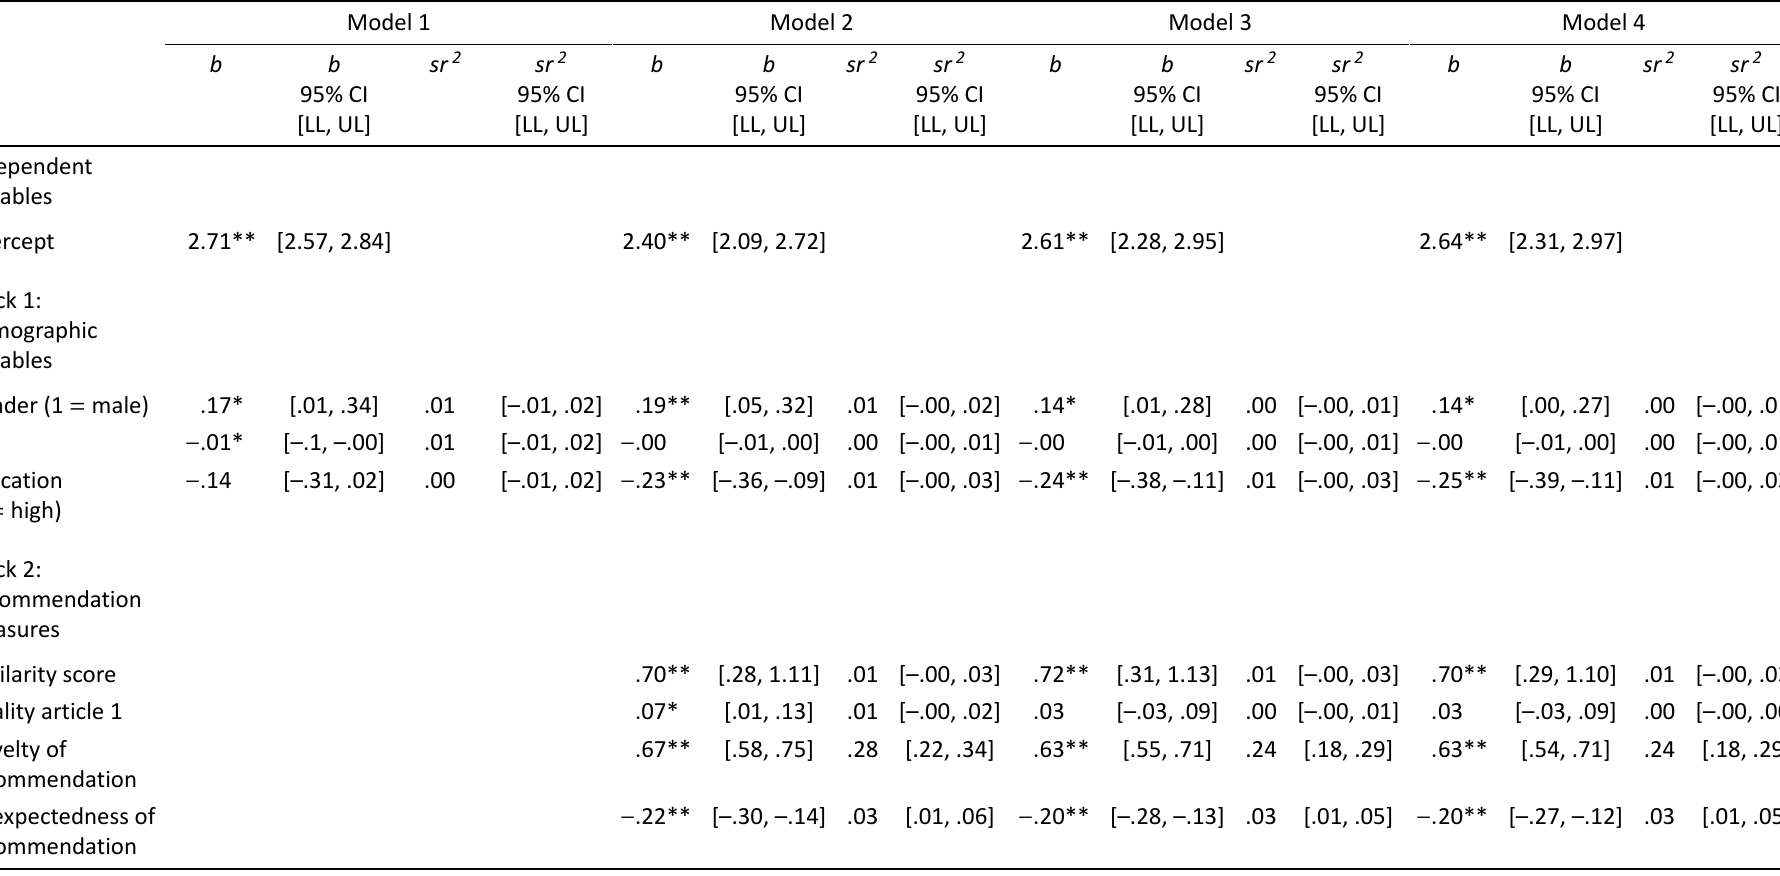
Table 1. Hierarchical regression predicting recommendation